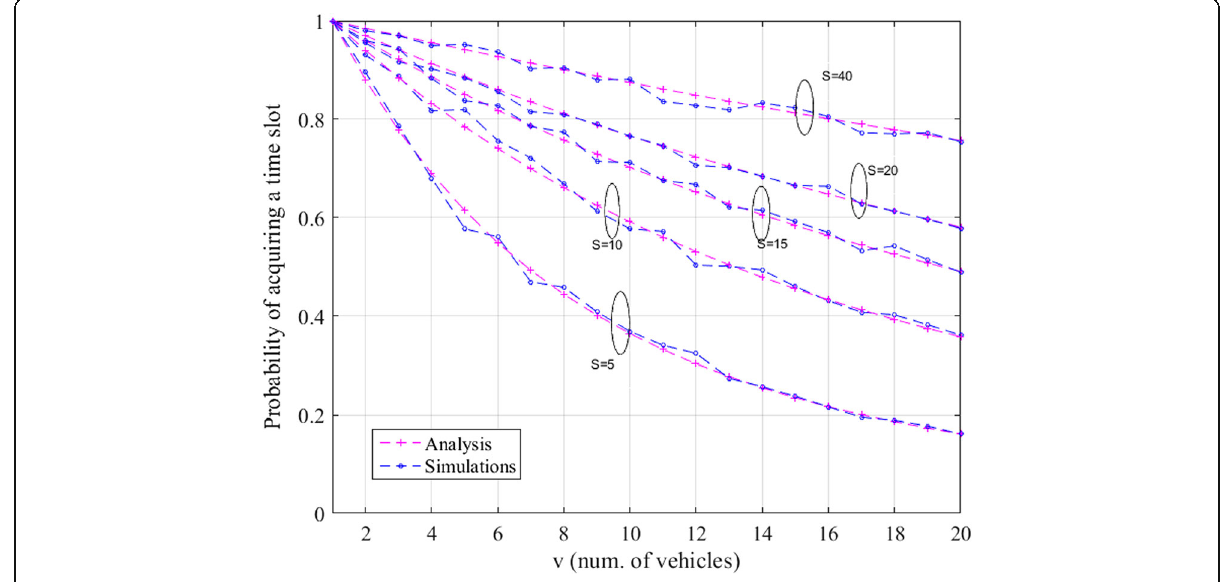
Fig. 11 The probability of acquiring a time slot “ HCMAC ” (analytical vs. simulation results, S = [5, 10, 15, 20, 40], W =